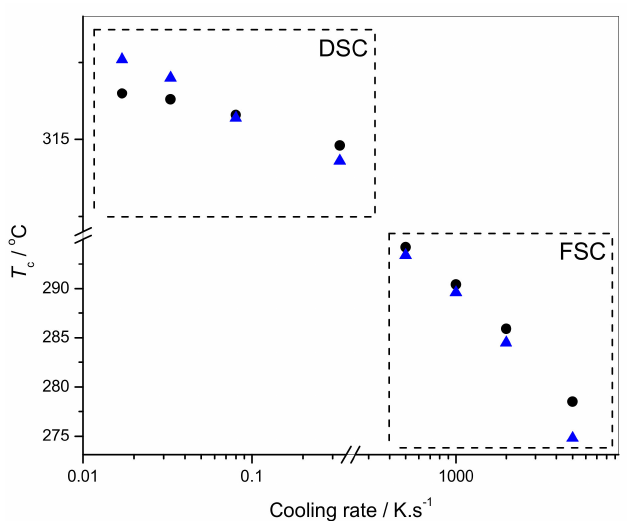
Figure 5. Crystallization temperatures obtained by DSC and FSC for non-isothermal crystallization from the melt at di ff erent cooling rates. Black dots: Neat polytetrafluoroethylene (PTFE); blue triangles: PTFE / SiO 2